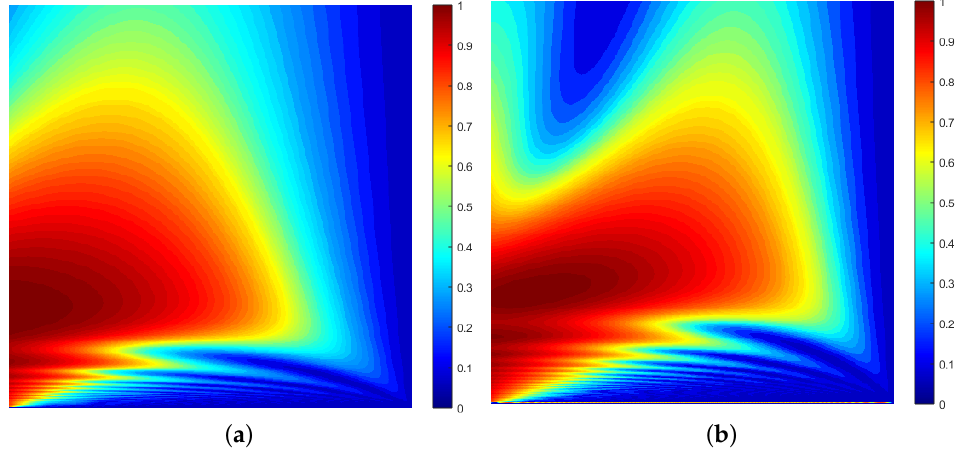
Figure 5. Examples of two time-diffraction maps. In both cases, the horizontal axis and the vertical axis, are of space x and time t , respectively, where ( 0,0 ) is the lower left-hand corner of the map. ( a ) Space-time map of the function | u ( x , t ) | 2 , x ∈ [ 0,1 ] , t ∈ [ 0 + ,1/ k ] where u ( x , t ) is given by Equation (68) for k = π ; ( b ) space-time map of the function | u ( x , t ) | 2 , x ∈ [ 0,1 ] , t ∈ [ 0 + ,1/ k ] where u ( x , t ) is given by Equation (68) for k = 2 π